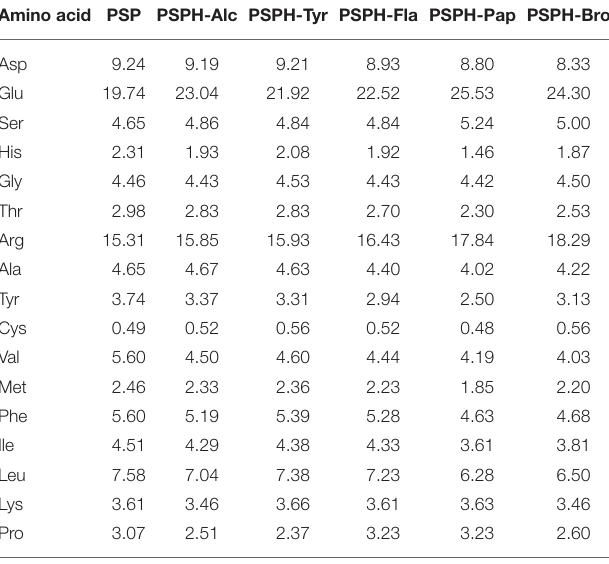
TABLE 1 | Amino acid composition of pumpkin seed protein and pumpkin seed protein